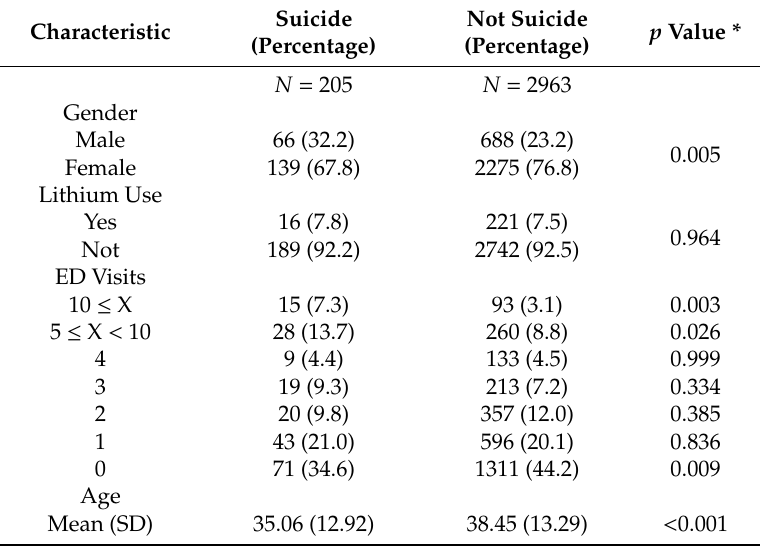
Figure 1. Inclusion process of patients with PTSD and bipolar disorder. Table 1. Baseline Patient